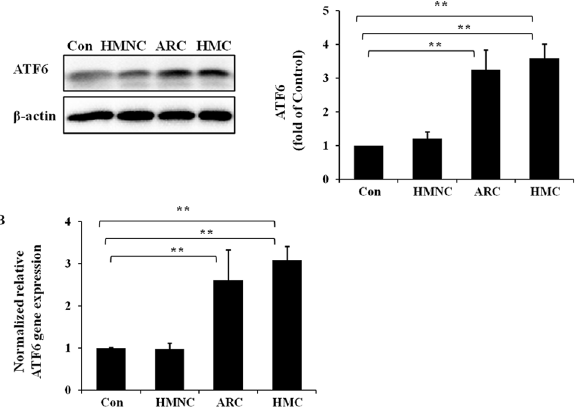
Fig 5. Up-regulation of cleaved ATF6 protein and gene expression levels in the lens epithelium of HMC patients. RNA and protein were extracted from HMC, HMNC, ARC or normal control (Con) human epithelium specimens. Western blotting was performed to detect the protein expression of cleaved ATF6 (Fig 5A), and β -actin was used as the internal control. Real-time PCR was performed to detect the relative gene expression level of ATF6 in each group (Fig 5B), and 18S was used as the internal control gene (mean ± SD, n = 3). * P < 0.05; ** P < 0.001.